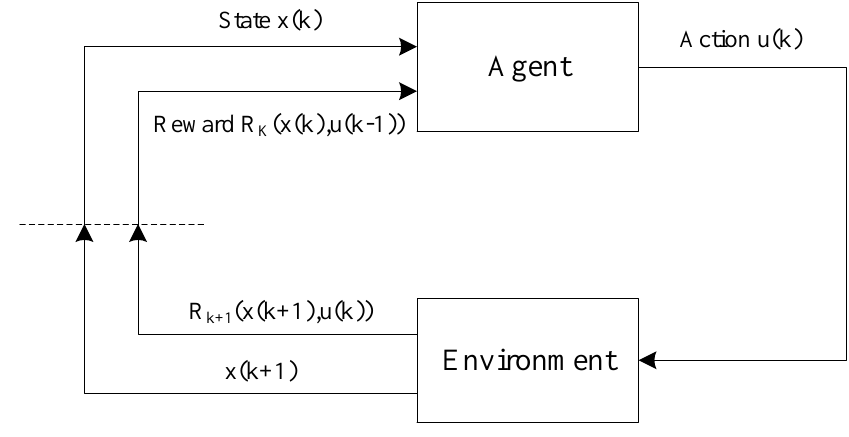
Figure 2. The basic frame of reinforcement